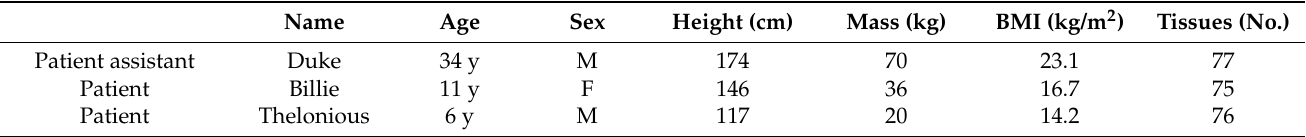
Table 1. Human body models.